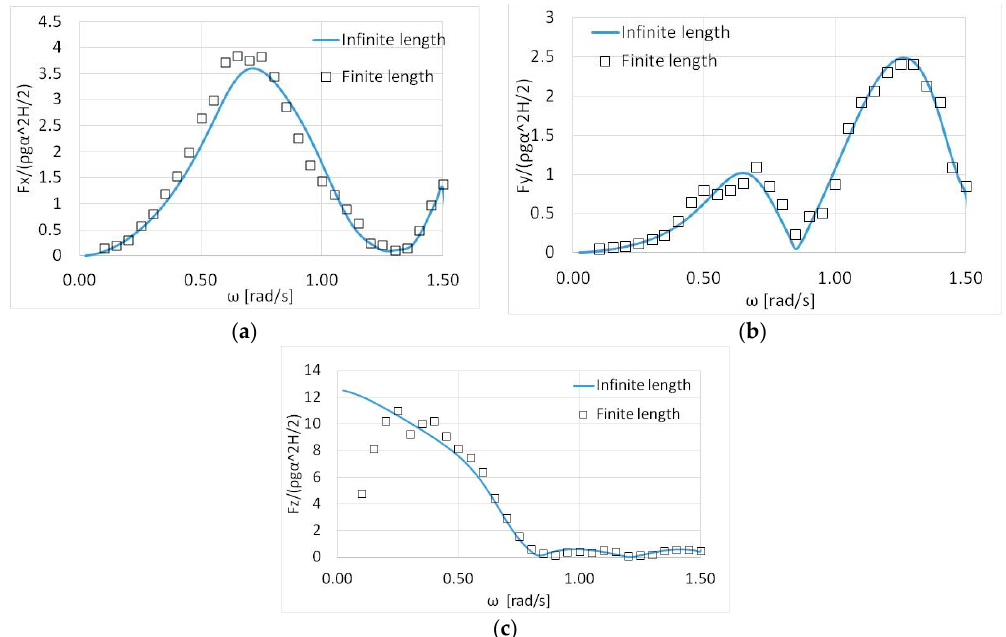
Figure 13. Exciting forces on a floating cylindrical floater placed in front of an orthogonal breakwater of finite length: ( a ) horizontal-exciting force on x -axis; ( b ) horizontal-exciting force on y -axis; ( c ) vertical-exciting force on z -axis. The results are compared with the corresponding values of the same floater placed in front of an infinite length orthogonal breakwater.